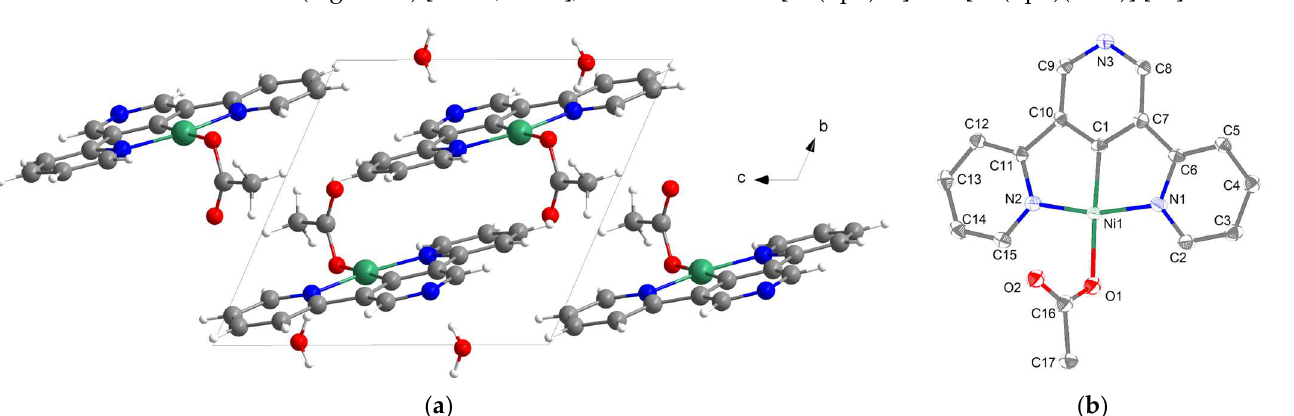
Figure 1. View of the crystal structure of [Ni(2,3′:5′,2″-terpy)Br 0.14 /OAc 0.86 ] . H 2 O along the a -axis ( a ) and ORTEP plot of the molecular structure with displacement ellipsoids at 50% probability; H atoms and the co-crystallised H 2 O were omitted for clarity ( b ). In both views, only the OAc coligand is shown, which makes 86% of the OAc/Br disorder. Table 2. Selected bond lengths (Å) and angles ( o ) a .